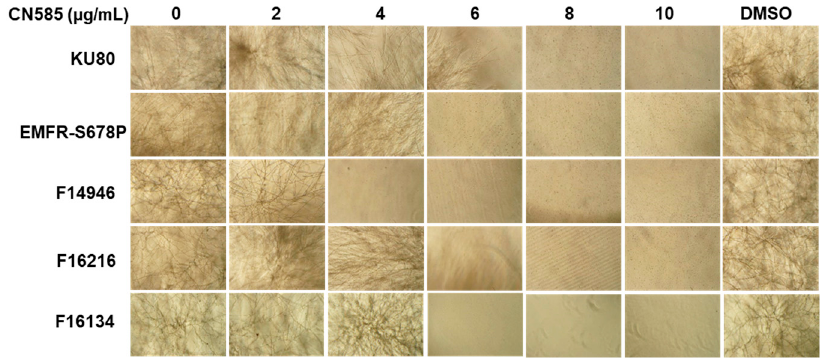
Figure 1. Growth of the wild-type A. fumigatus (KU80) and the echinocandin-resistant (EMFR-S678P) and the azole-resistant (F14946, F16216 and F16134) strains in the presence of increasing concentra- tions of CN585. DMSO control growth is shown. Growth was monitored for 2 days in RPMI at 37 °C. Light microscopy photographs (×10 magnification) after 2 days of growth are shown. Note the com- plete inhibition in growth at >8 µg/mL CN585. Growth susceptibility assays were performed three times in triplicate. in